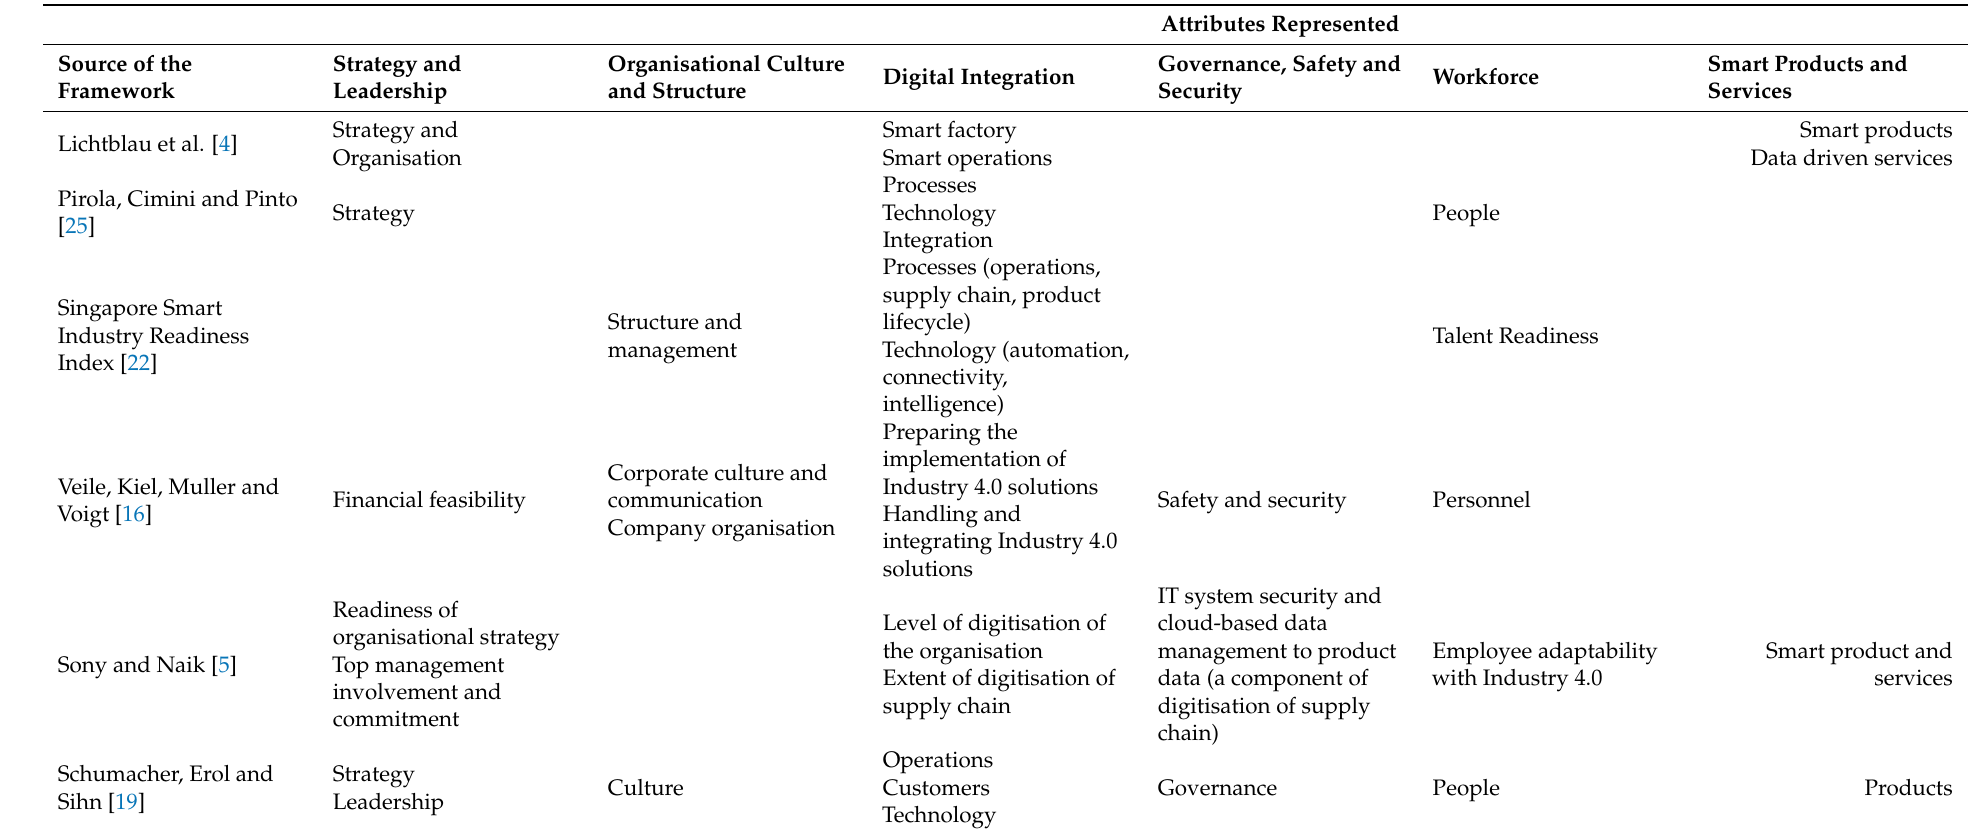
Table 1. Attributes represented in Industry 4.0